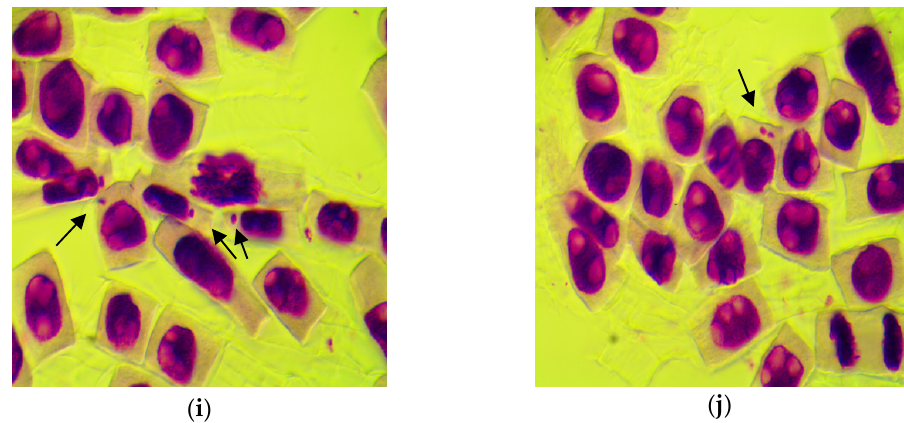
Figure 7. Microphotographs with different types of genetic abnormalities in wheat root meristem cells induced by various concentrations of Merlot and Sauvignon blanc grape marc extracts: ( a ) multipolar anaphase with multiple whole bridges ( b ) early telophase with one whole and several broken multiple bridges; ( c ) telophase with a whole bridge and several broken bridges; ( d ) telophase with two whole bridges; ( e ) two telophases: one with whole bridge, one with two broken bridges; ( f ) telophase with two broken bridges; ( g – i ) interphases with one micronucleus each; ( j ) interphase with two micronuclei (magnification: 1000×).